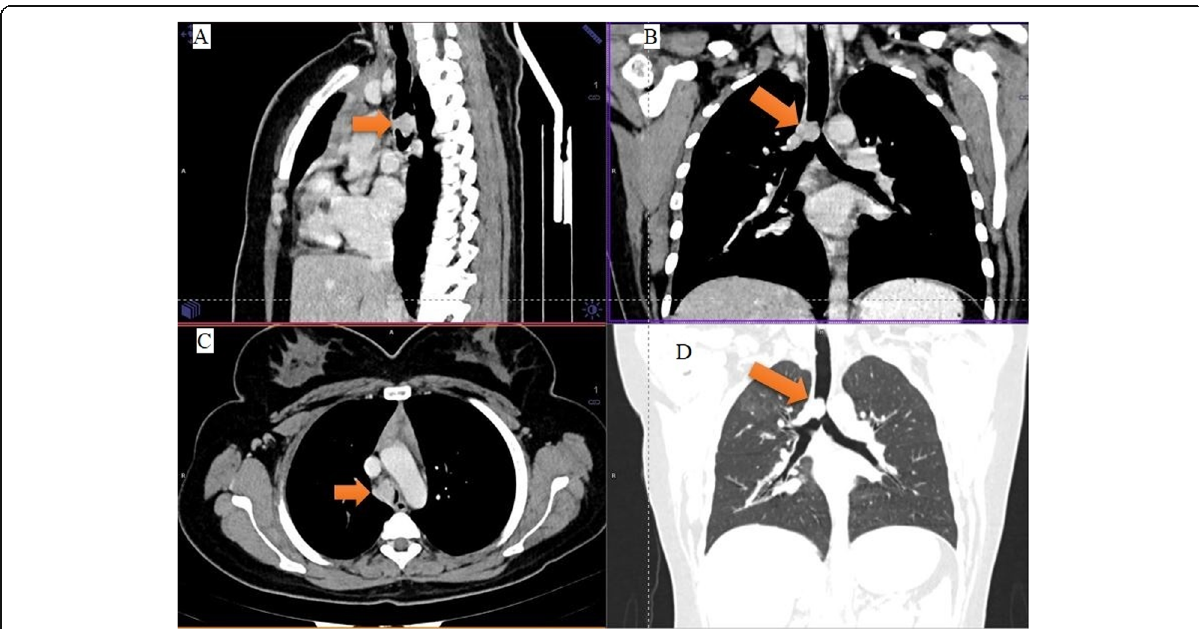
Fig. 1 Sagittal ( a ), coronal ( b ), axial ( c ), and lung window ( d ) views of CT scans of thorax show a well-defined polypoidal soft tissue density lesion (solid yellow arrows) on the right posterolateral side of trachea at T4 vertebral level with gross luminal compromise, just proximal to carina with no extra luminal extension, laryngotracheal deviation, and lung collapse